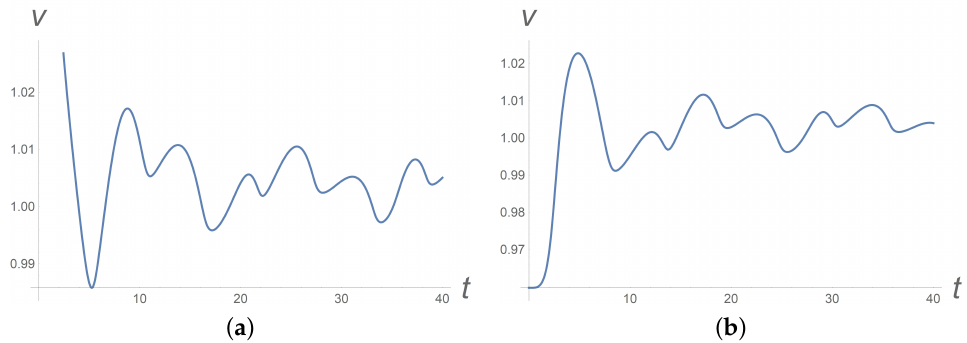
Figure 5. Time variation of the velocity in the middle of the channel at a constant pressure gradient in dimensionless variables ( a ) for homogeneous transversal initial particles orientation and ( b ) for non-homogeneous initial particles orientation along the